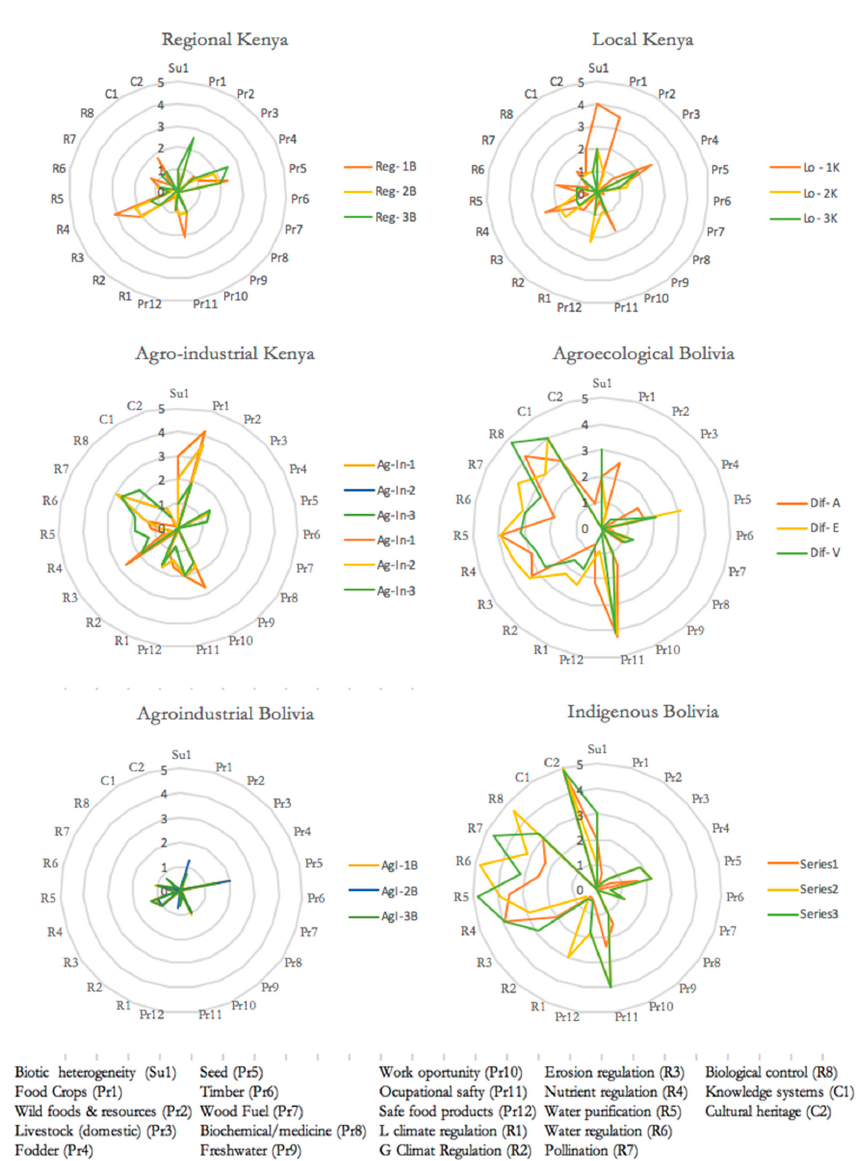
Figure 9. Capacity of the farm-based agroecosystems to provide the 23 farm-based agroecosystem